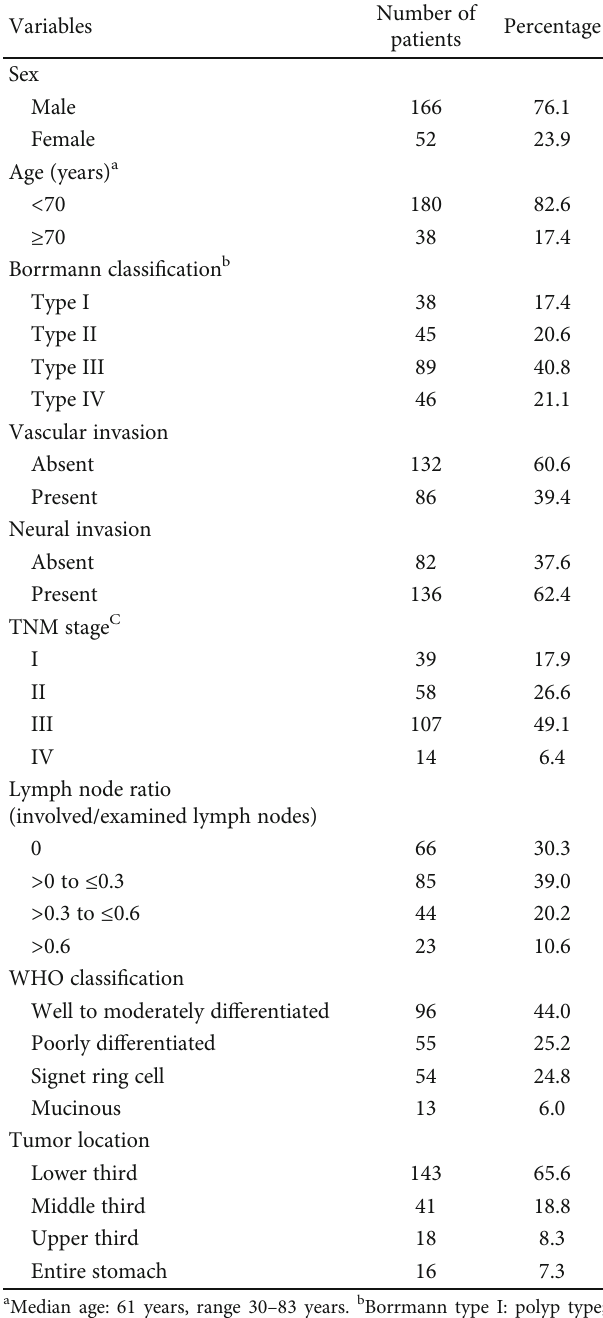
Table 1: Patient characteristics.